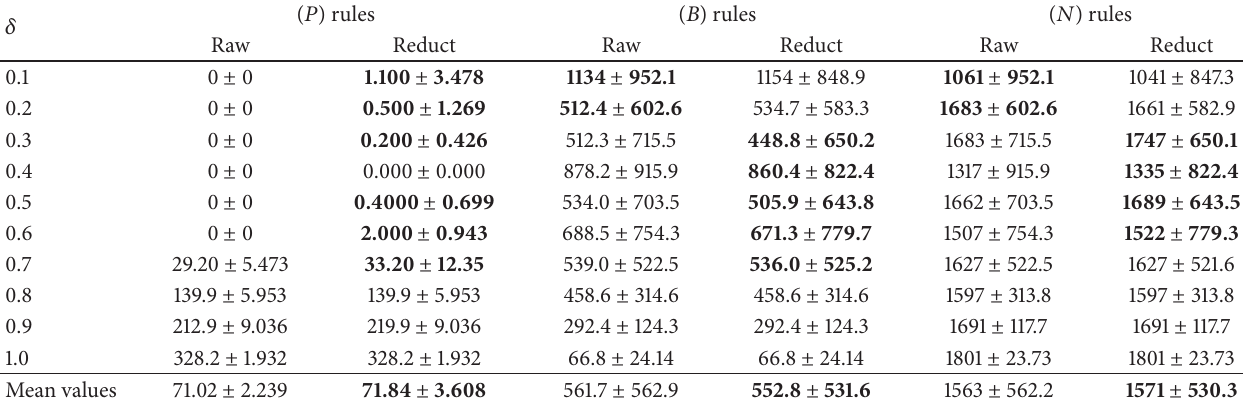
Table 3: The decision rules between raw data and decision-monotonicity criterion based reducts (Dermatology).